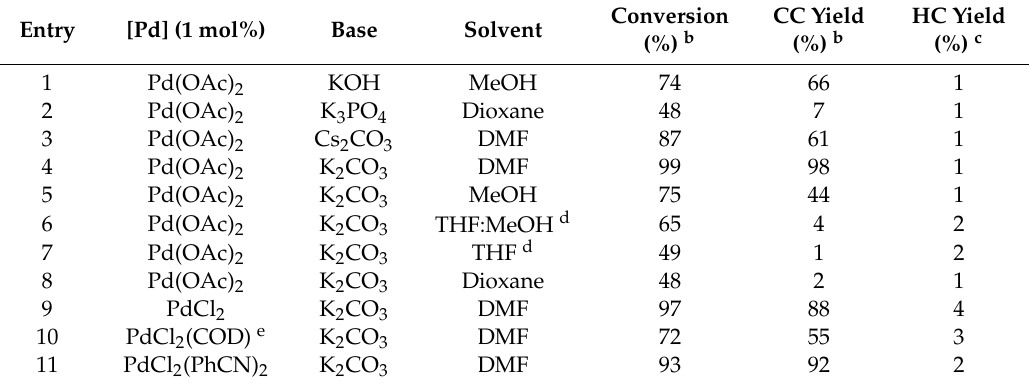
Table 1. Solvent, base and Pd source effects on the model SM cross-coupling (CC) reaction using ligand 2a .